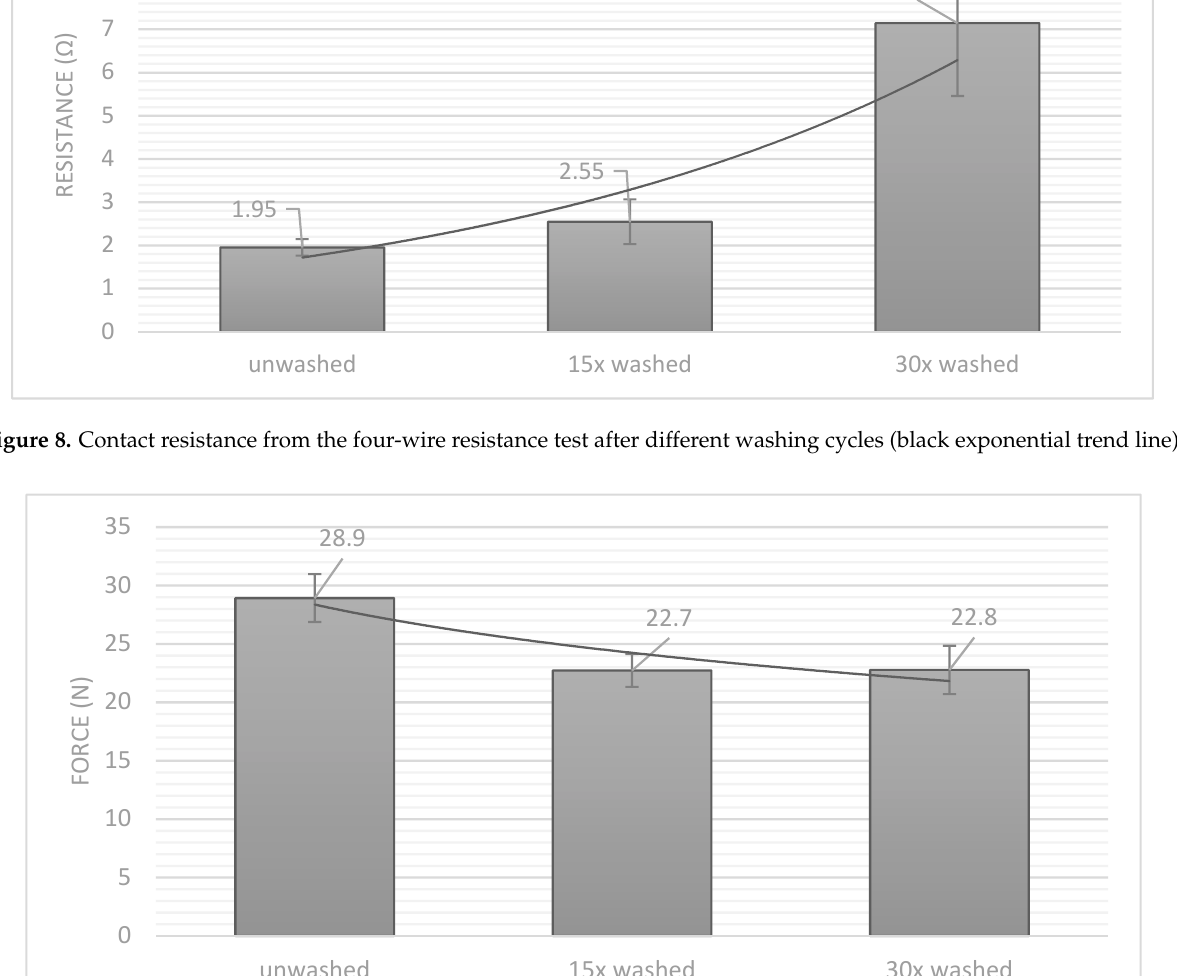
Figure 8. Contact resistance from the four-wire resistance test after different washing cycles (black exponential trend line).